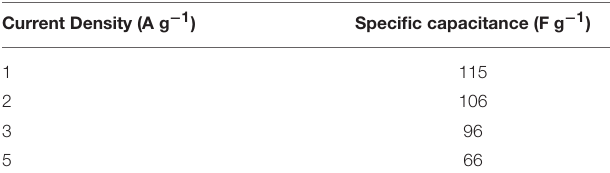
TABLE 2 | Specific capacitance of hollow and porous NaFePO 4 form CD curves in 2M NaOH electrolyte. Current Density (A g − 1